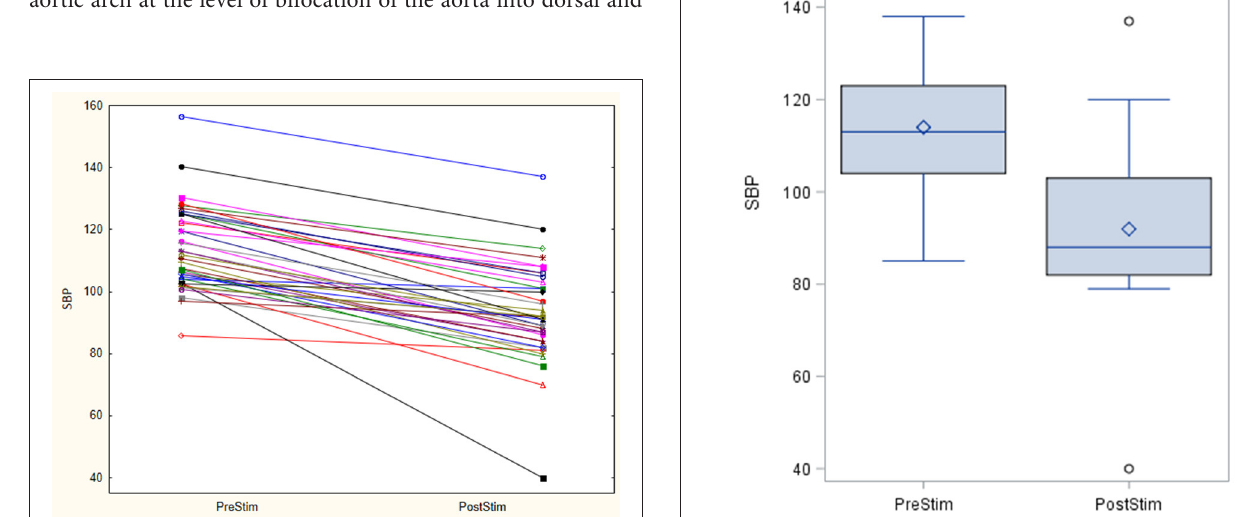
Frontiers in Cardiovascular Medicine |